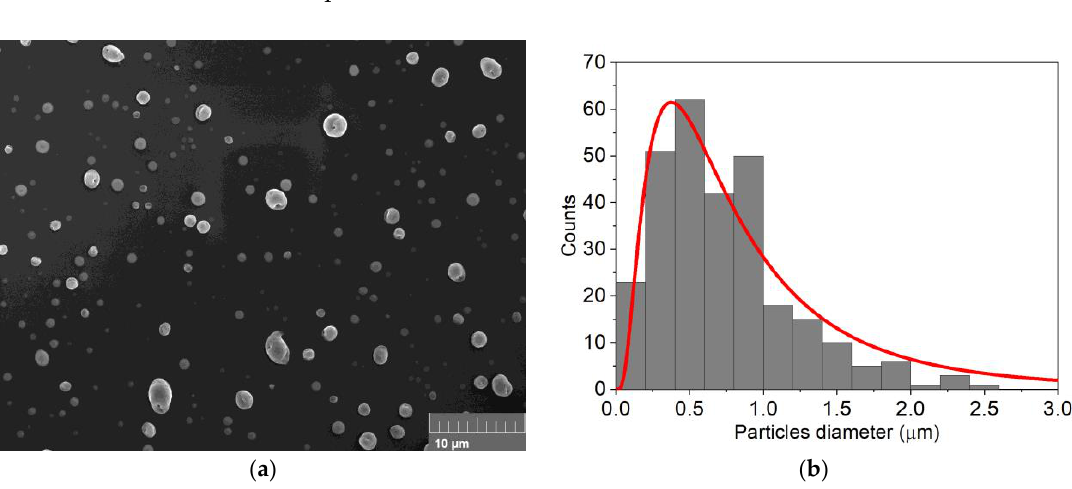
Figure 4. ( a ) SEM analysis of 30 nmol of Se deposited on n-Si (sample B); ( b ) particles distribution obtained from the SEM image.